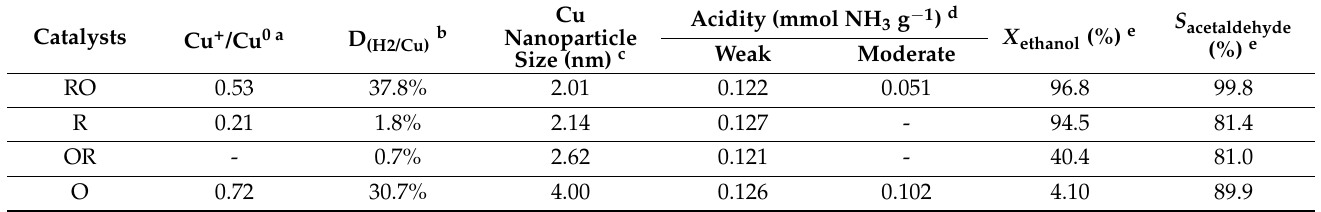
Table 2. The texture structure of the Cu/KIT-6 catalyst under different treatment